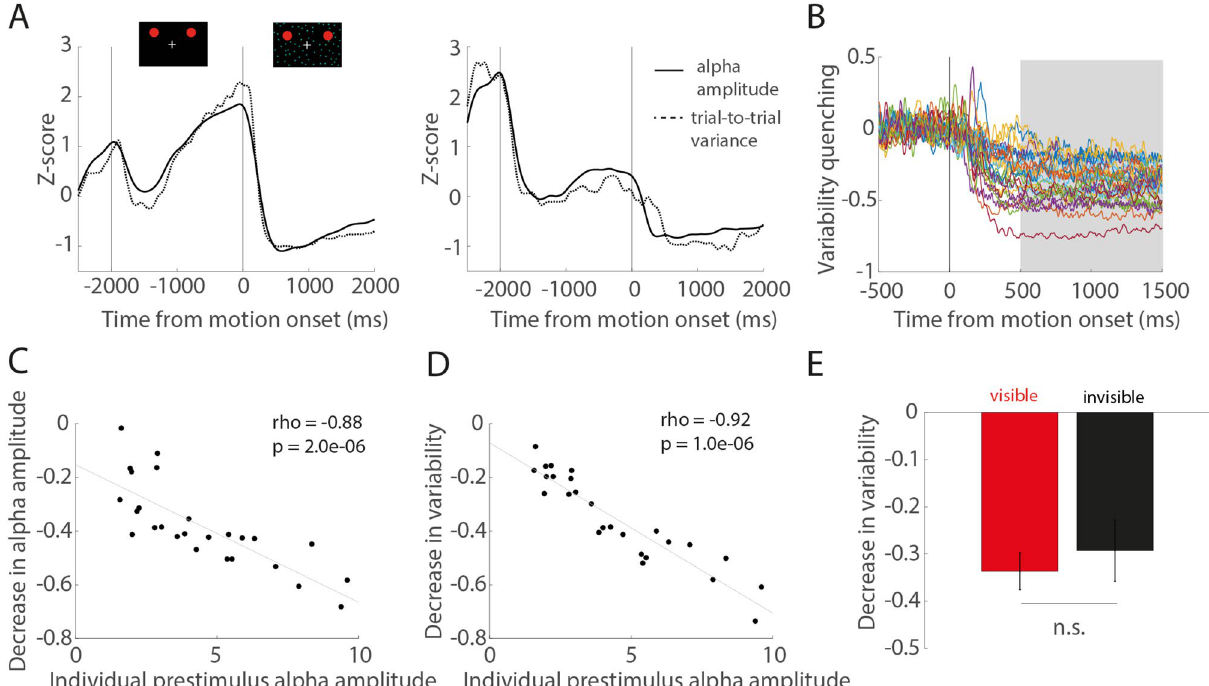
Figure 3. Quenching of trial-to-trial variability and relation to prestimulus alpha amplitude. ( A ) Average variance across trials (z-score, dotted line) and alpha amplitude (z-score, black line) over the course of experimental trials for two example subjects. ( B ) Individual relative variance per subject (outlier corrected > 2SD, N = 26) and post stimulus time window used to define the individual degree of variability quenching. ( C ) Relation of decrease in alpha amplitude to individual alpha amplitude in the prestimulus interval, N = 26. Each dot represents one subject. Spearman’s rank correlation coefficient and corresponding p value. The gray line represents the least-squares fit. ( D ) Relation of the individual degree of variability quenching to individual alpha amplitude in the prestimulus interval, N = 26. Spearman’s rank correlation coefficient and corresponding p value. The gray line shows the least-squares fit. ( E ) Mean change in variance with RDM stimulus onset (trial-to-trail variability quenching) for visible and invisible trials across subjects (N = 26). Error bars indicate + / − 1